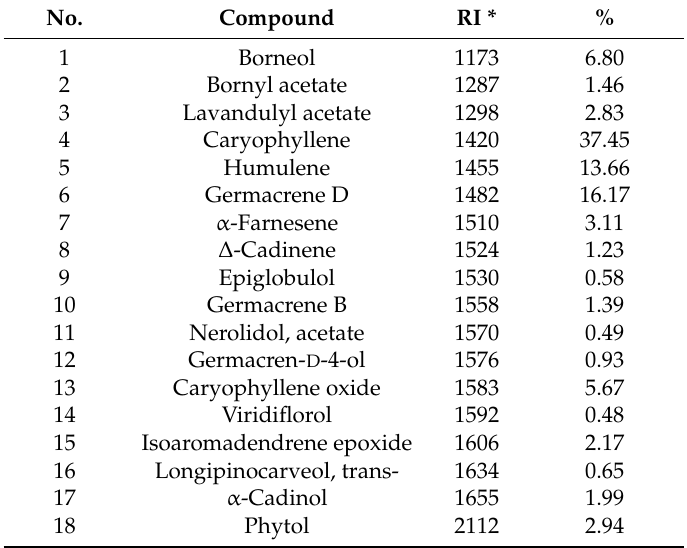
Table 1. Chemical composition (%) of Artemisia vulgaris essential